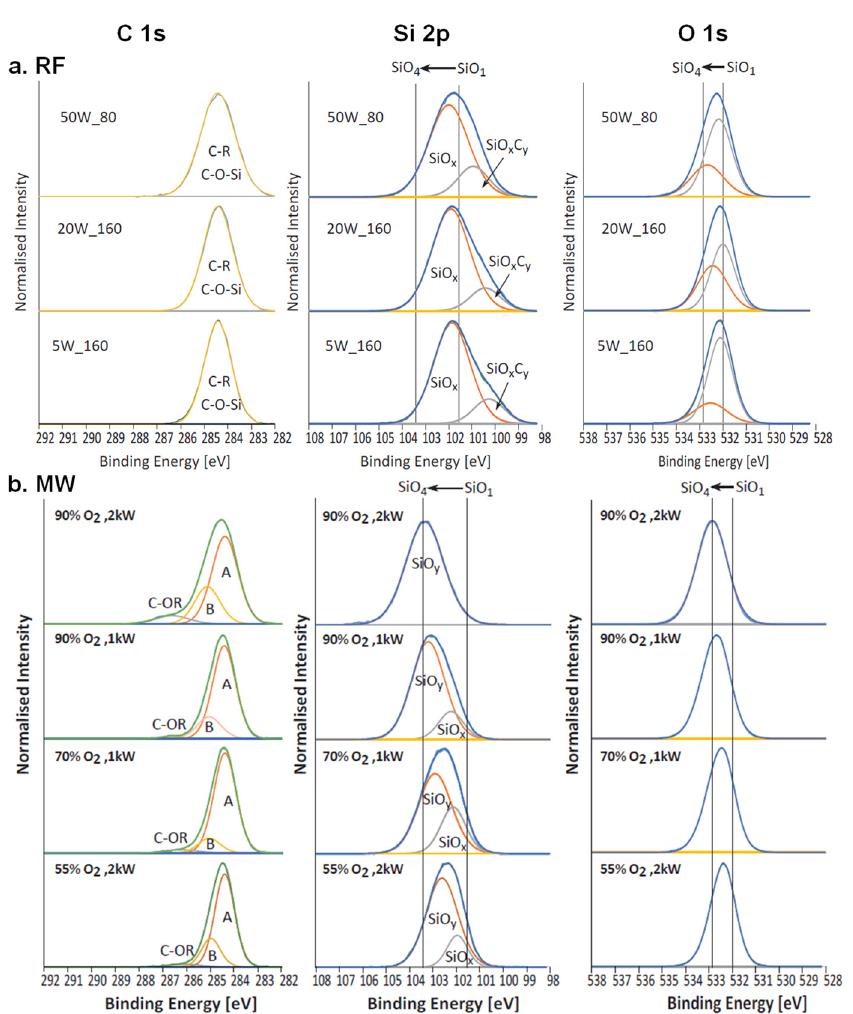
Figure 2. XPS high-resolution C 1s, Si 2p, and O 1s spectra for ( a ) RF and ( b ) MW TMDSO films deposited at varying powers and O 2 concentrations.